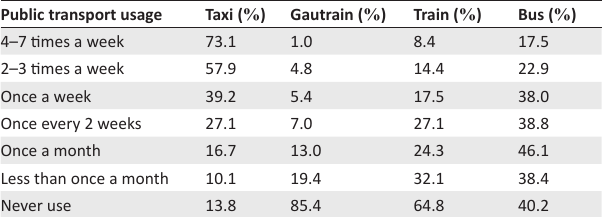
TABLE 1: Public transport usage.